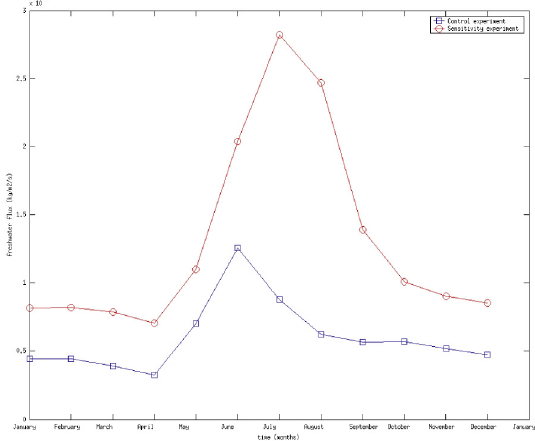
Fig. 6. Seasonal cycles of surface runoff (freshwater forcing, kgm − 2 s − 1 ) along the Greenland coast, for the control experiment (blue curve) and the sensitivity experiment (red